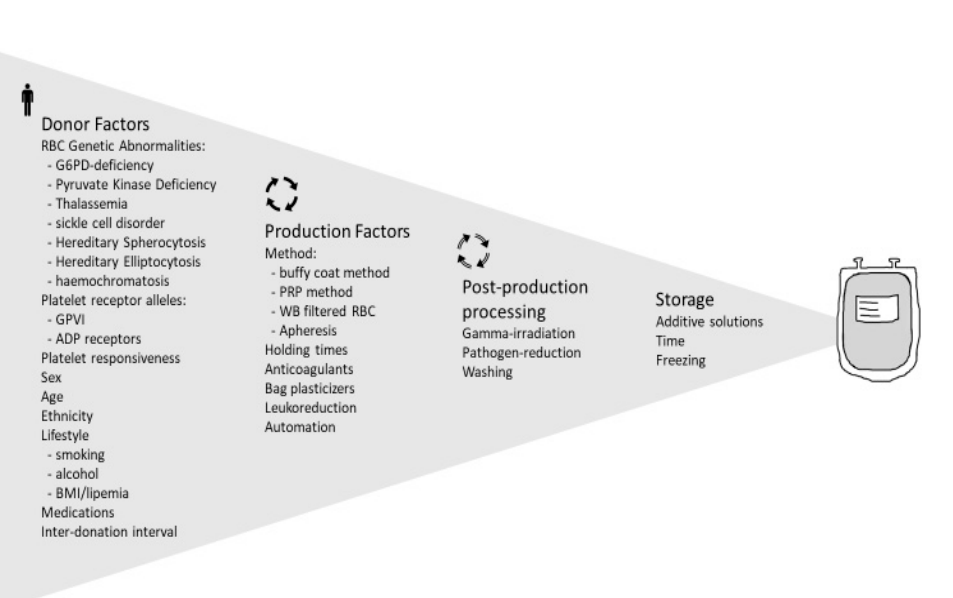
Figure 1. Sources of variability in blood manufacturing. Donor factors contribute substantially to variability affecting blood product quality. RBC (red blood cells), G6PD (glucose-6-phosphate dehydrogenase), GPVI (glycoprotein VI), BMI (body mass index), WB (whole blood). Created by Dr. Katherine Serrano.